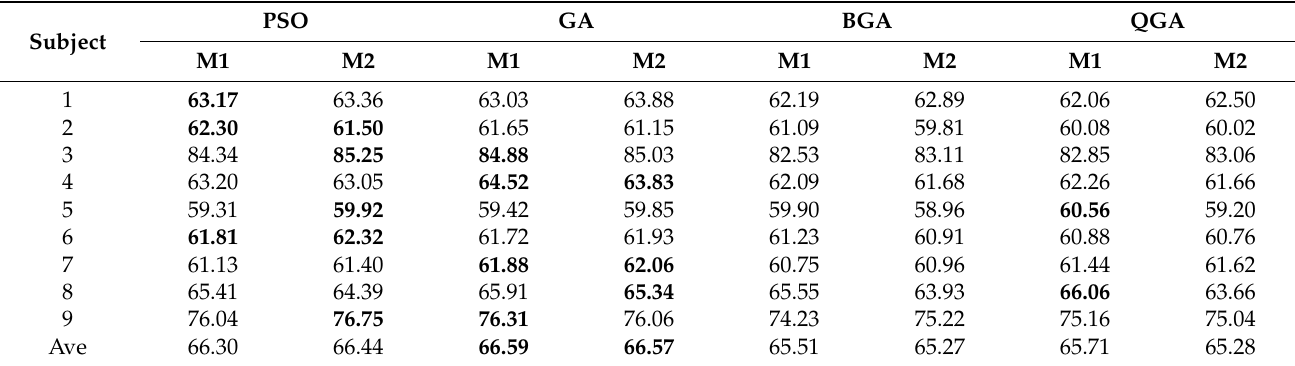
Table 14. The results of algorithms with four methods (TD, FD, wavelet, and autoregression) on three channels (C3 = 8 and CZ = 10 and C4 = 12) with FB 2 & 5